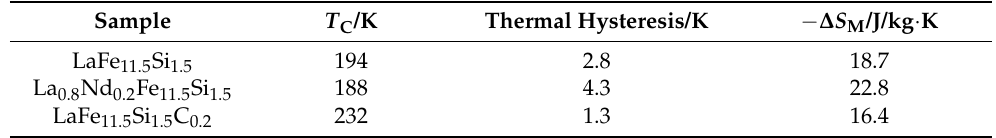
Figure 5. Magnetic entropy change in LaFe 11.5 Si 1.5 , La 0.8 Nd 0.2 Fe 11.5 Si 1.5 , and LaFe 11.5 Si 1.5 C 0.2 as a func- tion of temperature for an external magnetic field change of 0–3 T.